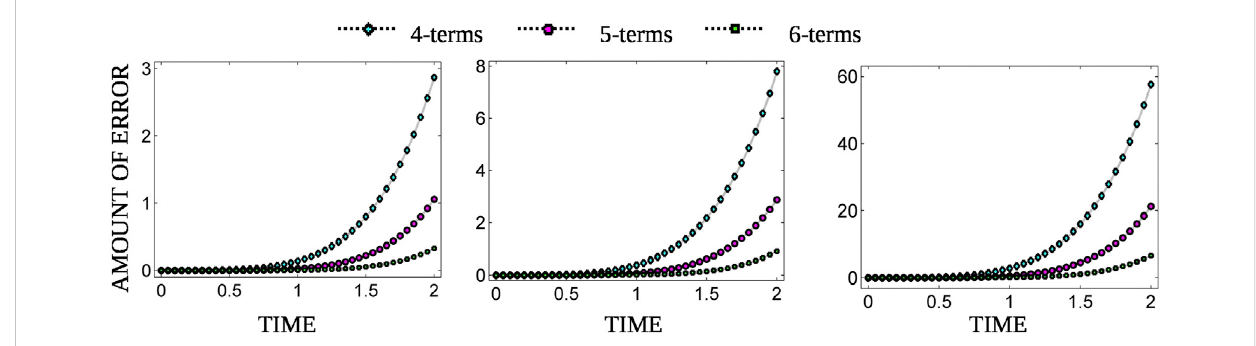
FIGURE 1 Error estimations for the casting process at β = 1 and x = 0.5, 1, 2.